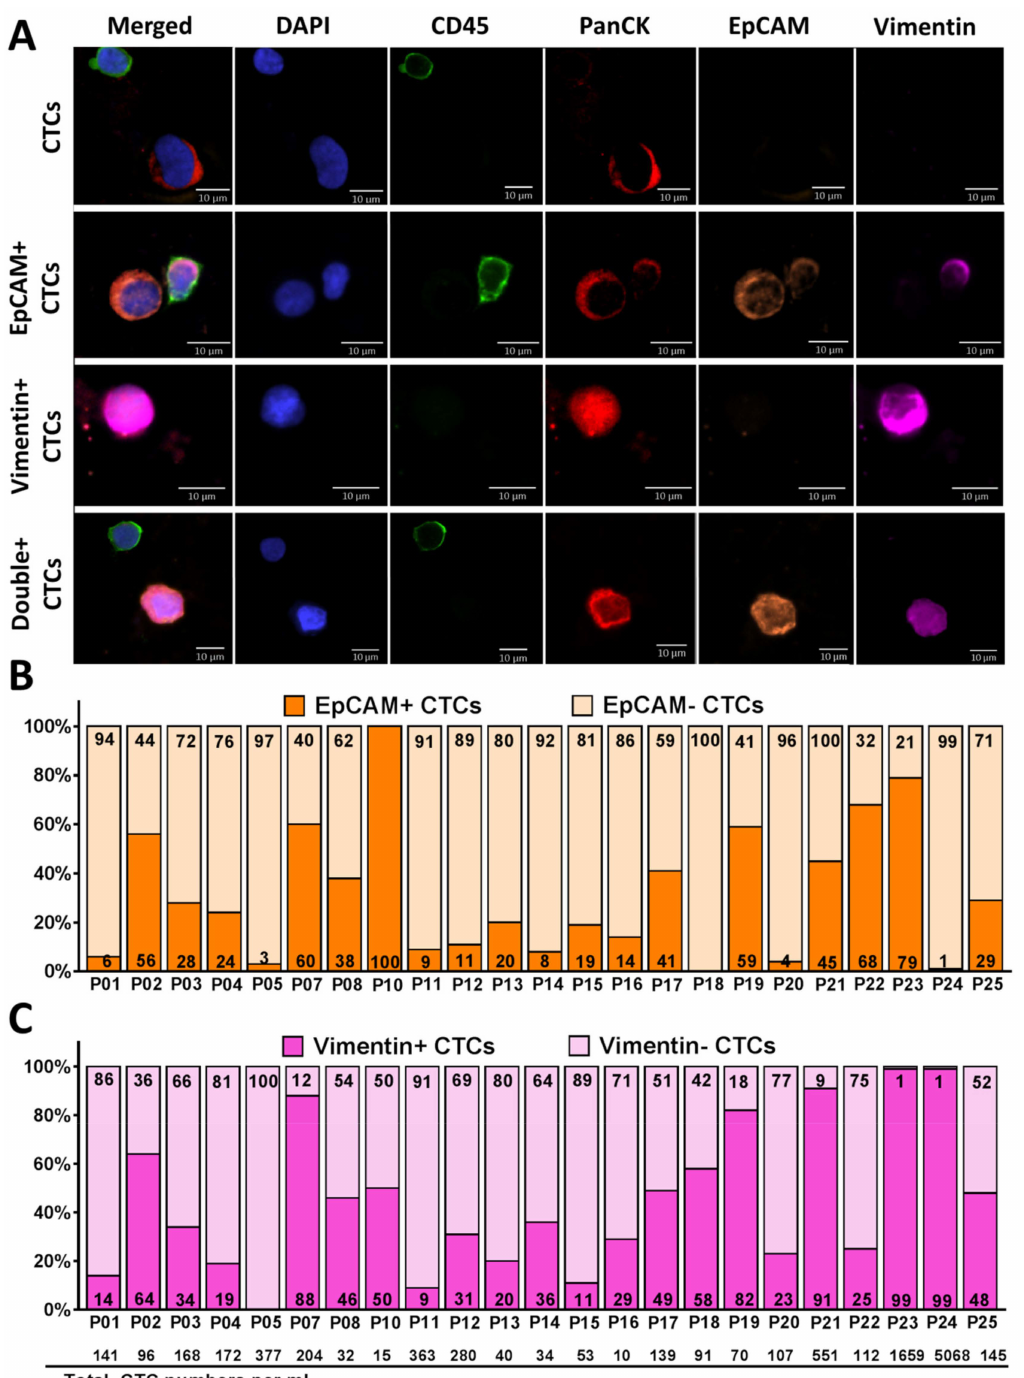
Figure 3. Identification of heterogeneous CTC subpopulations isolated from NSCLC patient samples ( n = 23). ( A ) Fluorescent microscope images of di ff erent subpopulations of CTCs (CTCs, EpCAM + CTCs, Vimentin + CTCs, and Double + CTCs). Cells are stained with DAPI (blue), CD45 (green), PanCK (red), EpCAM (orange), and Vimentin (pink). ( B , C ) The percentage of CTCs expressing both EpCAM ( B ) and Vimentin ( C ) recovered from each NSCLC patient sample ( n = 23). The EpCAM +/ − CTCs is shown in dark / light orange respectively and the Vimentin +/ − CTCs is shown in dark / light pink respectively. An average of 31% of the captured CTCs were EpCAM + and 69% were EpCAM − CTCs. An average of 45% of the captured CTCs were Vimenin + and 55% were Vimentin − CTCs. The total number of CTCs / mL across all patient samples is shown on the bottom of the